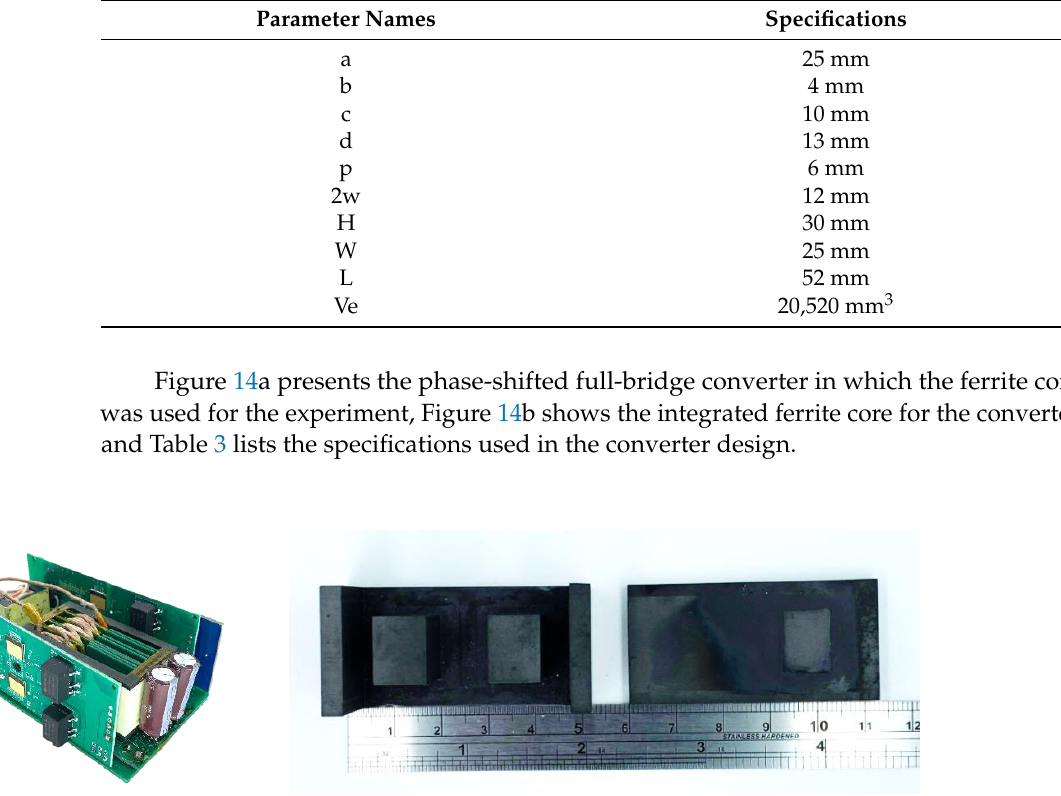
15 of 19 Figure 13. Core loss graph with β and  substituted into the calculation: ( a ) curve representing loss according to β value